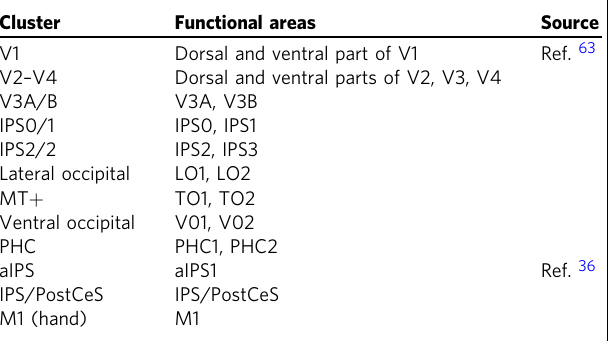
Table 1 De fi nition for the sensorimotor